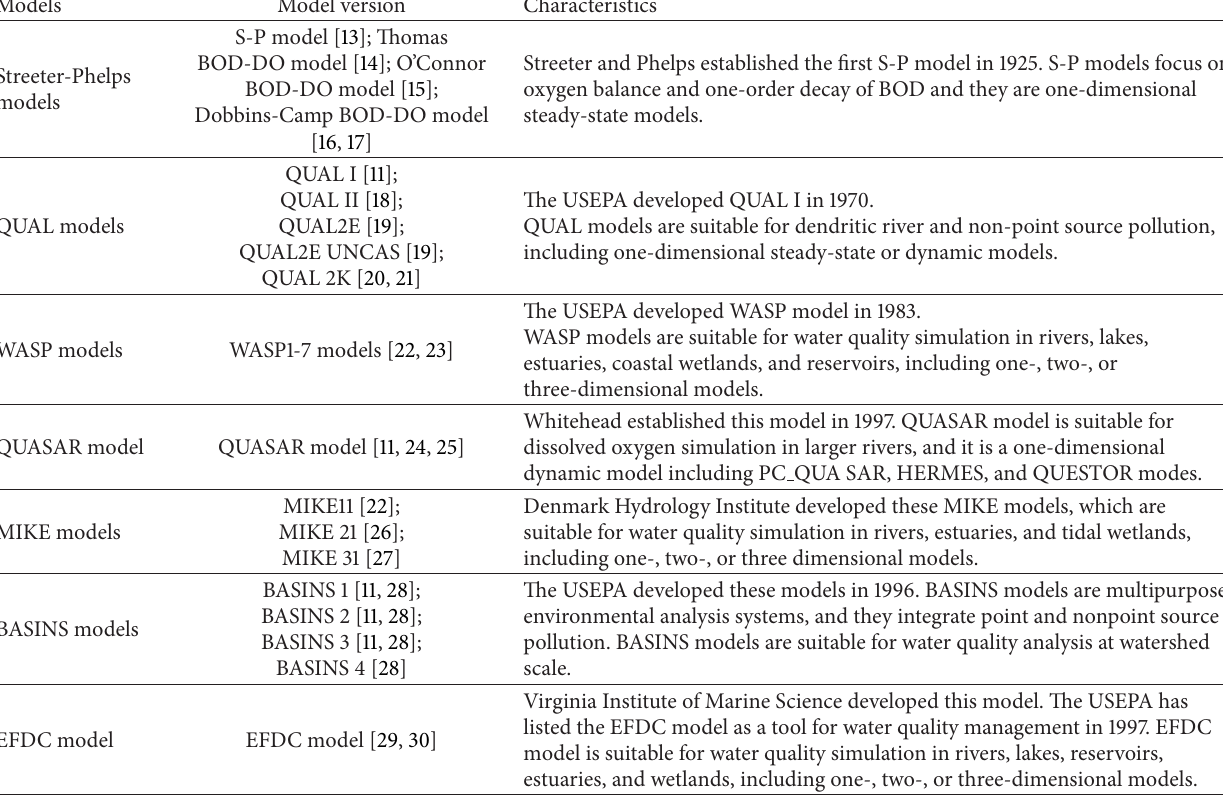
Table 1: Main surface water quality models and their versions and